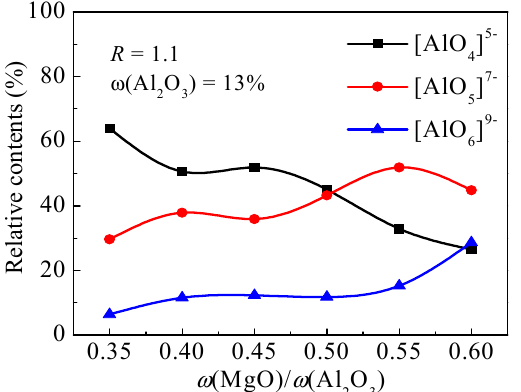
Figure 13. Relative content curves of [AlO 4 ] 5 − , [AlO 5 ] 7 − , and [AlO 6 ] 9 − with various ω (MgO)/ ω (Al 2 O 3 ) ratios.